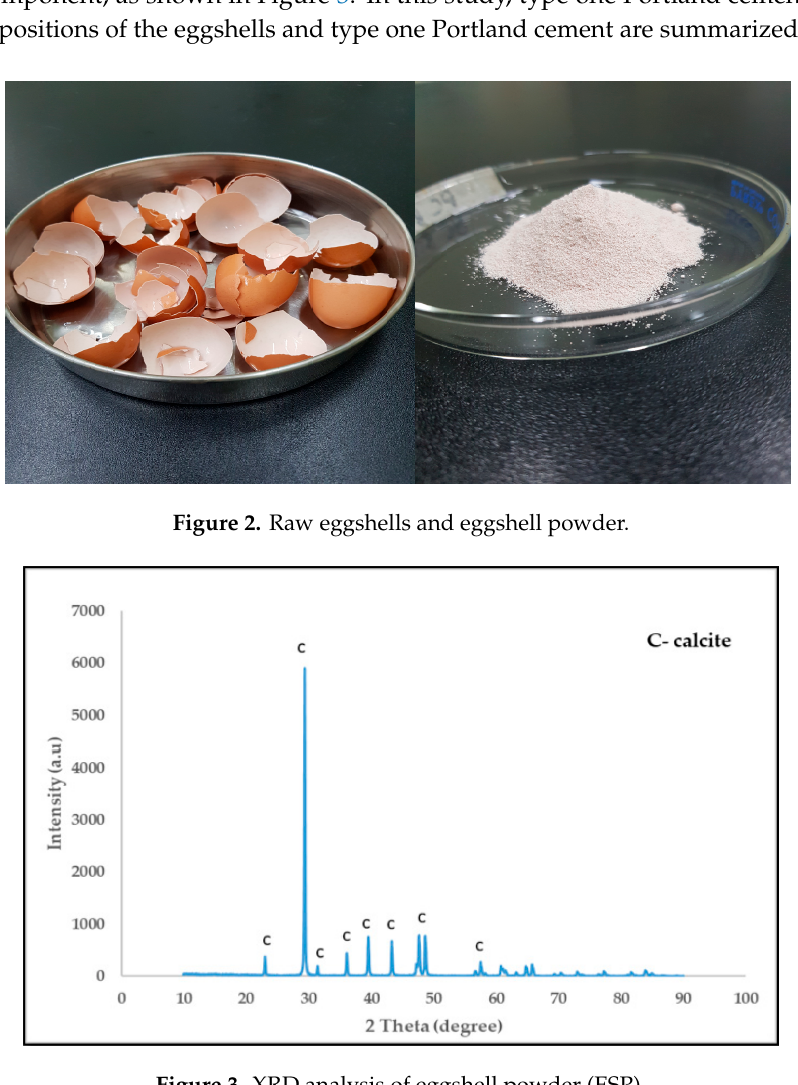
Figure 3. XRD analysis of eggshell powder (ESP). Table 1. Chemical composition of Portland cement and